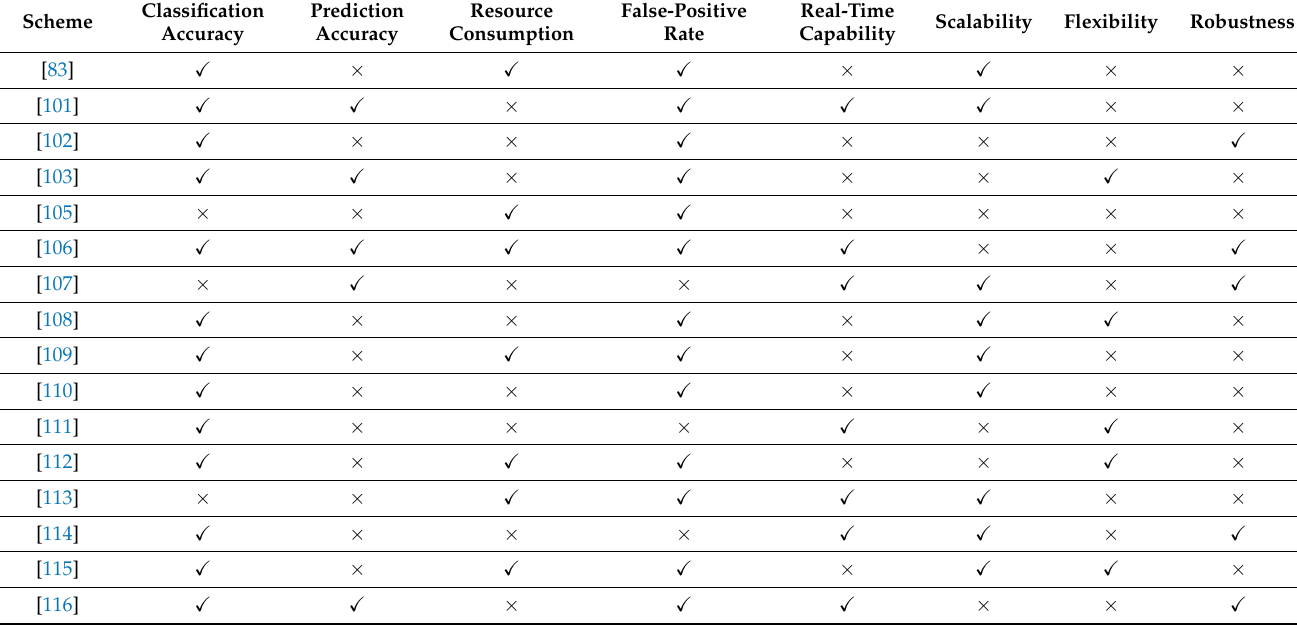
Table 7. A comparison of deep anomaly-based IDS approaches in